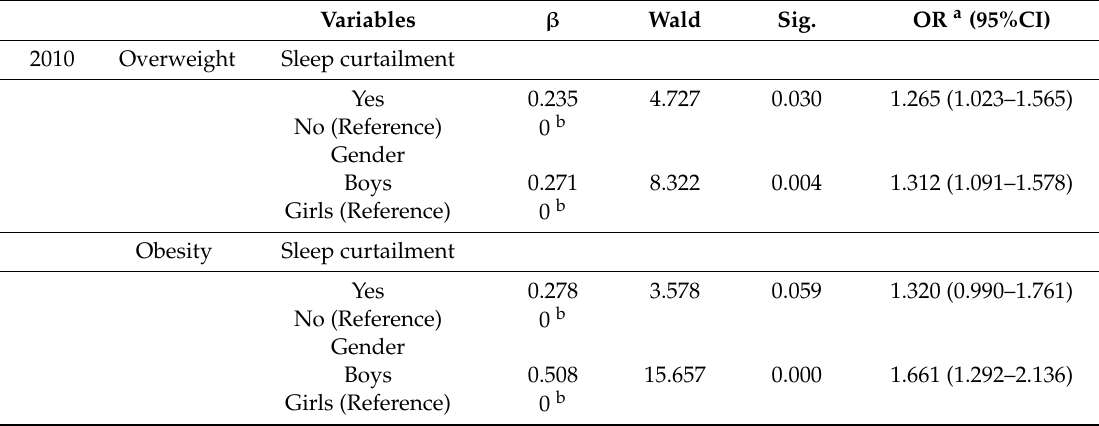
Table 8. Association between sleep curtailment and overweight or obesity stratified by age group in 2010 and 2014 (13–15-year age